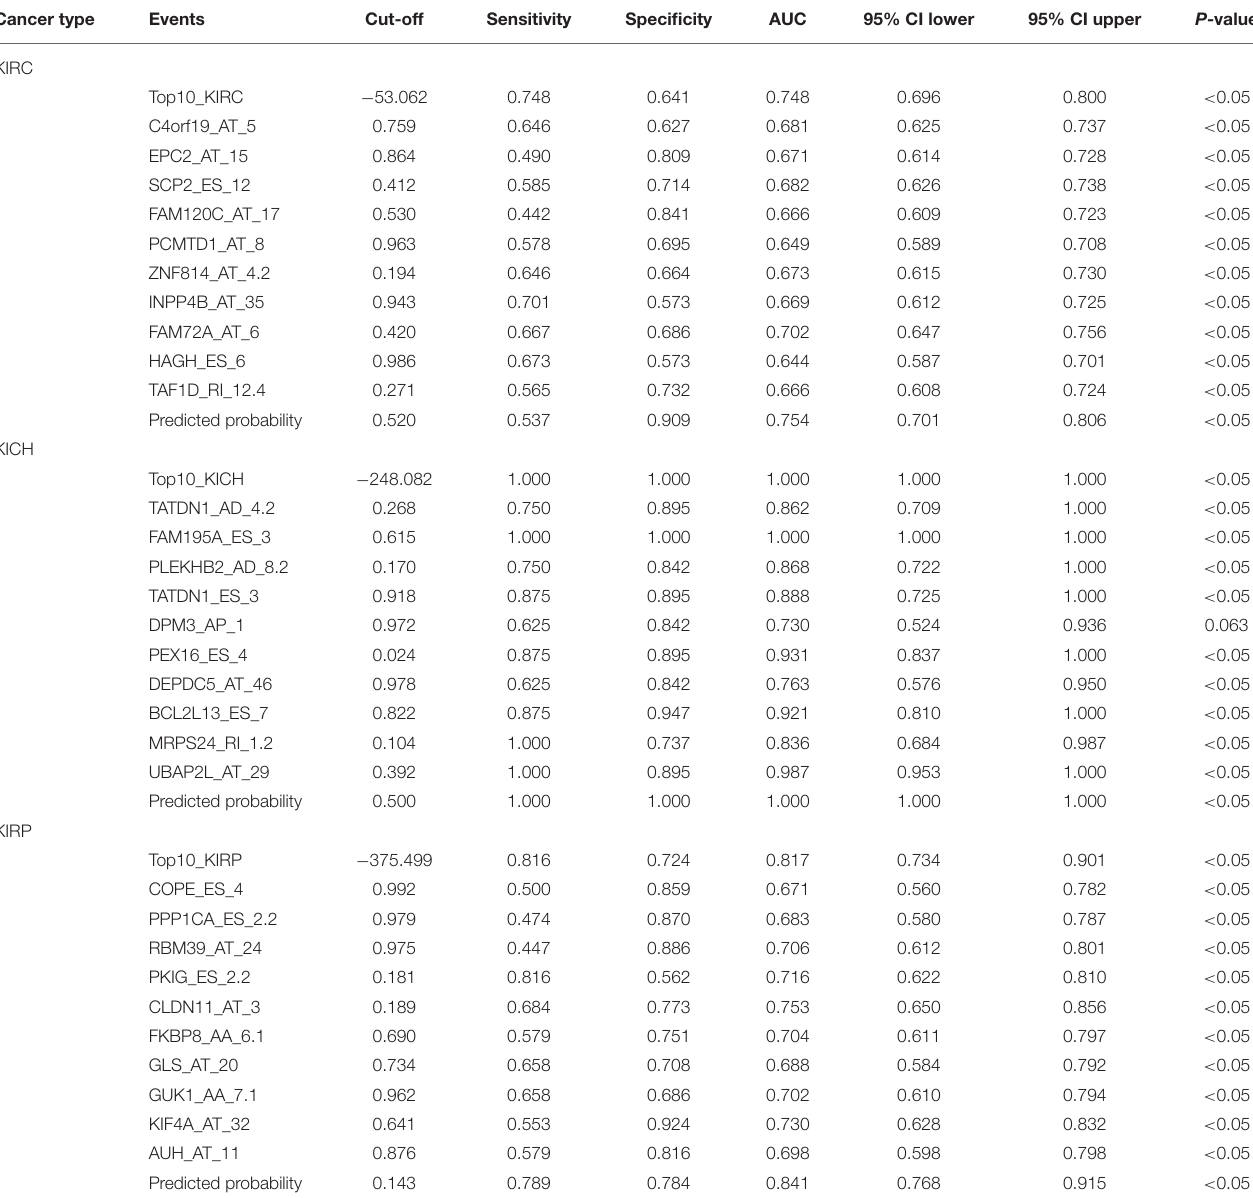
TABLE 2 | ROC curve results of survival related factors in predicting 5 year survival. Cancer type Events